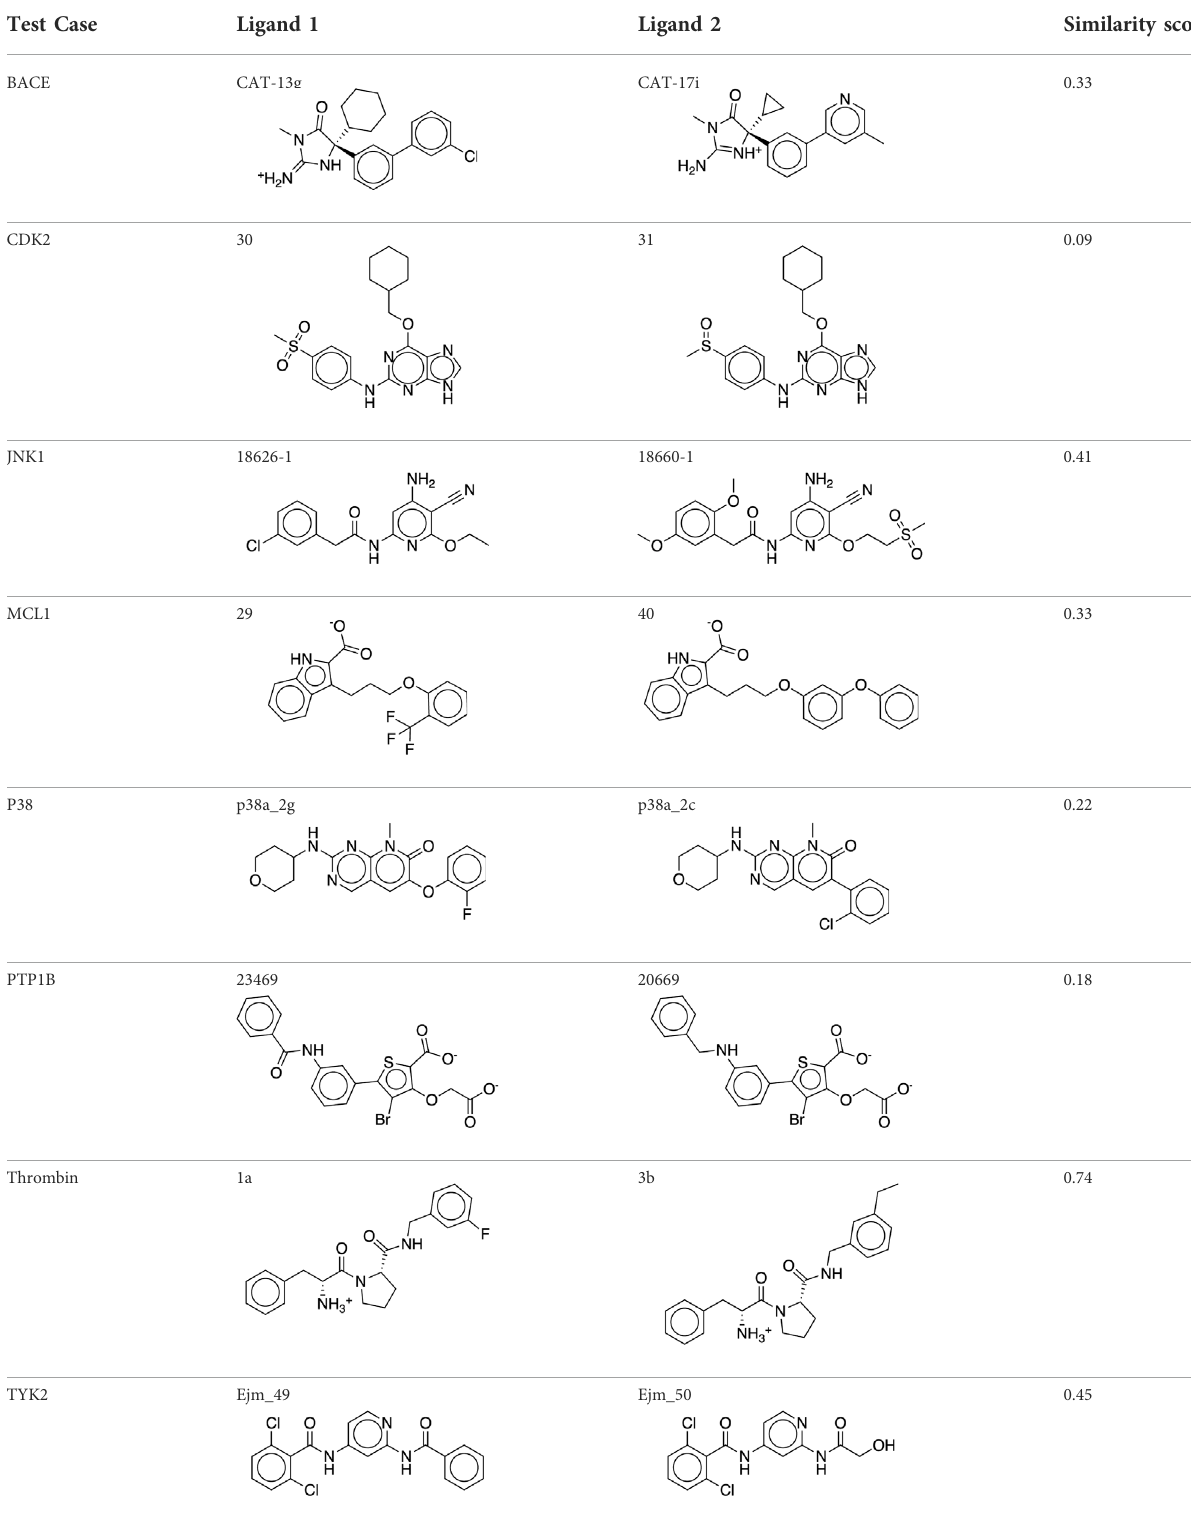
TABLE 3 The representative perturbations used to explore convergence for the eight test